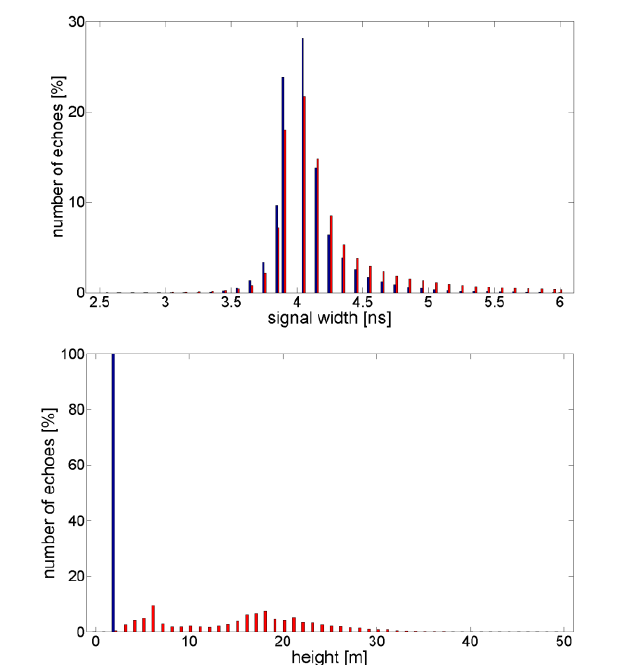
Figure 4: Distribution of features signal width (a) and height (b) for water (blue) and land